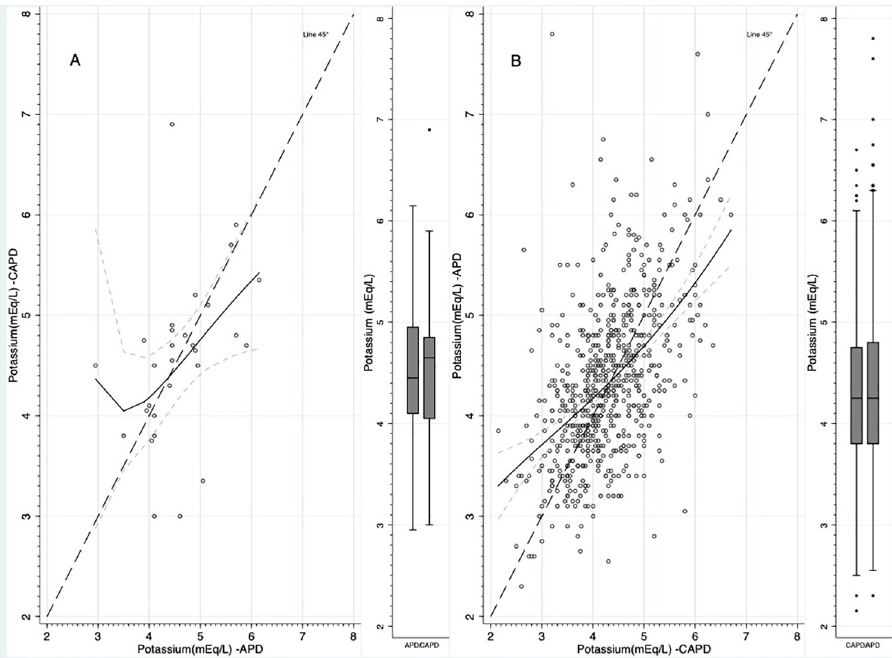
Fig 5. Potassium serum levels. A. Starting on CAPD and switching to APD; B Starting on APD and switching to CAPD. The continuous black line was predicted with fractional polynomials. The dashed gray lines are the 95% confidence interval for continuous black line. The boxplots depict the mean value, interquartile range and min. max. values of potassium during the time on CAPD and APD.